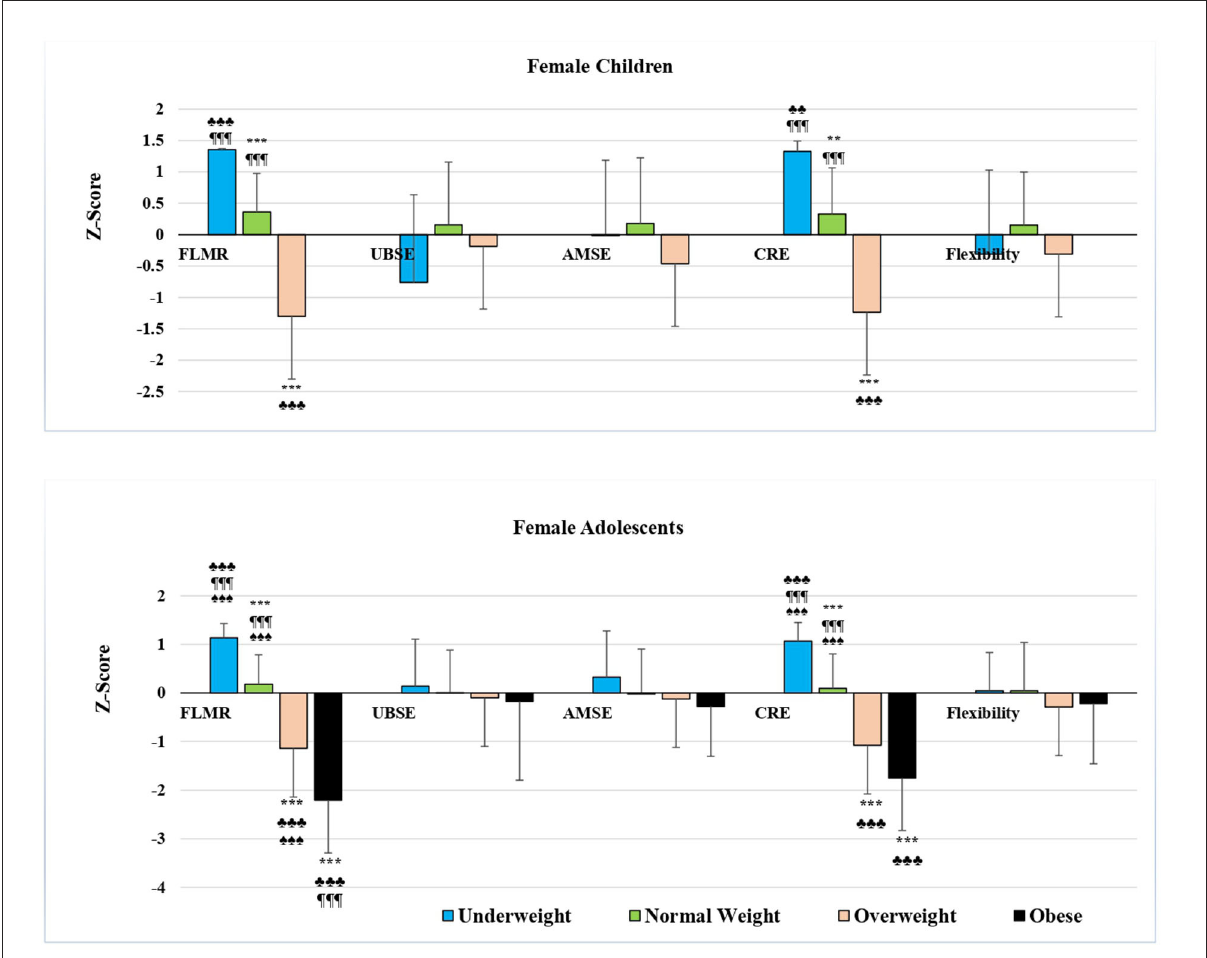
FIGURE2 Mean Z-score of health-related physical fitness components in female students by age and BMI category. FLMR, Fat-to-lean mass ratio; UBSE, Upper body strength and endurance; AMSE, Abdominal muscular strength and endurance; CRE, Cardio-respiratory endurance * p < 0.05, ** p